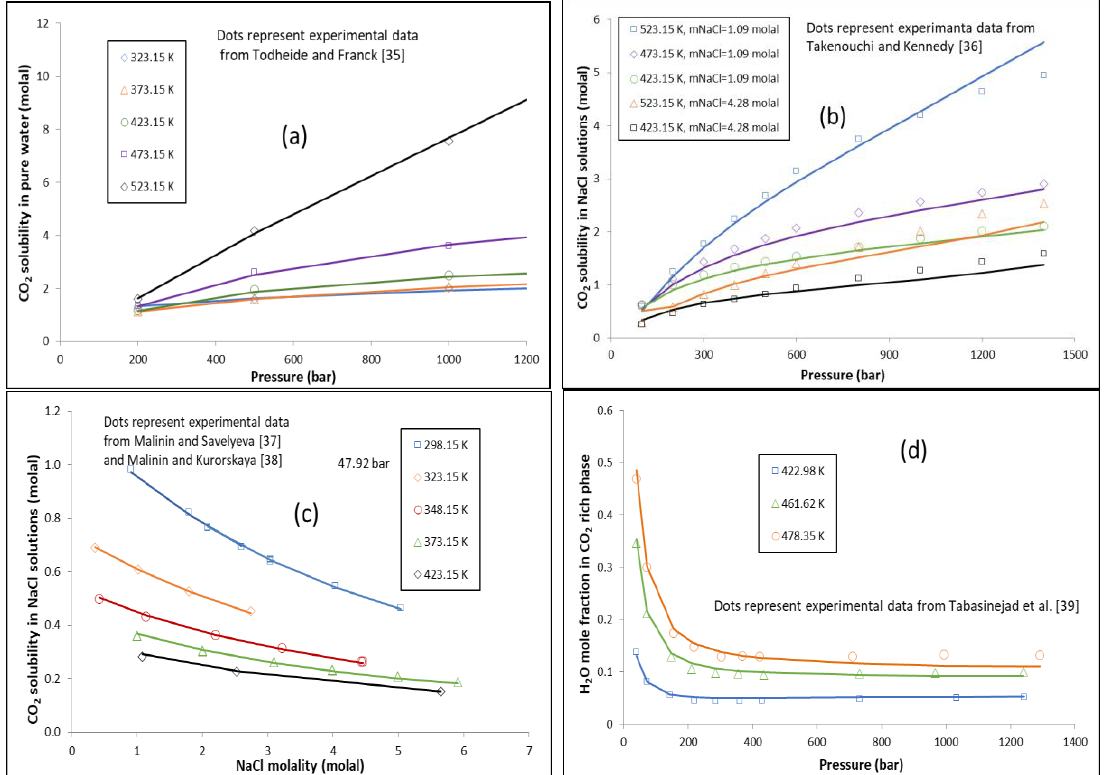
Figure 1. CO 2 -brine system mutual solubility from experimental data [35–39] (dots) and results calculated by this model (lines) at various temperatures, pressures and salinities. ( a ) CO 2 solubility in pure water. ( b ) CO 2 solubility in NaCl solutions varying with pressure at different temperature and NaCl molality. ( c ) CO 2 solubility in NaCl solutions varying with NaCl molality at different temperatures and pressures. ( d ) H 2 O solubility in CO 2 -rich phase at different pressures and temperatures.